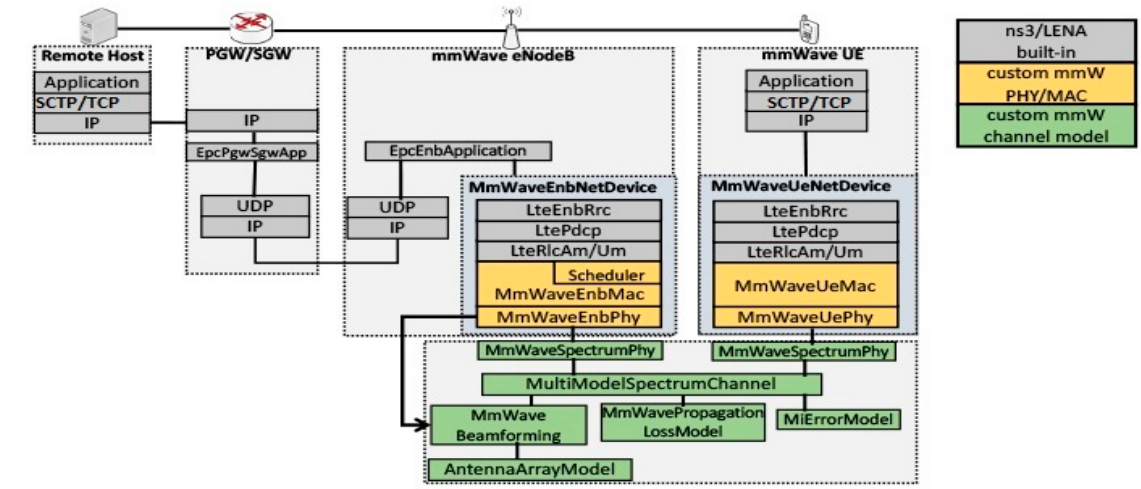
Figure 4. Simulation setup. mmWave: millimeter wave; PGW: core gateway; SCTP: stream control transmission protocol; TCP: transmission control protocol.